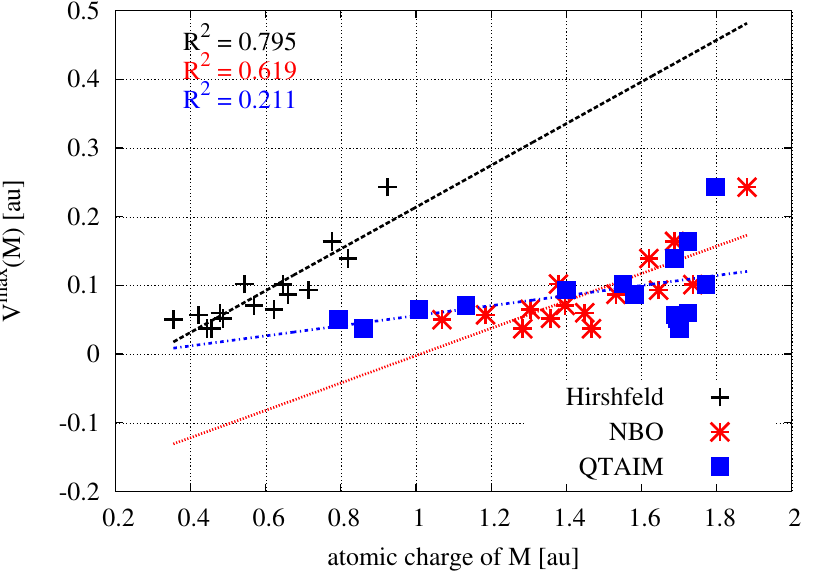
Figure 4. Relationships between the atomic charge of the M metal atom in MX 2 (M = Be, Mg, Zn; X = H, F, Cl, Br, Me) and the maximum value of the electrostatic potential on the surface of this